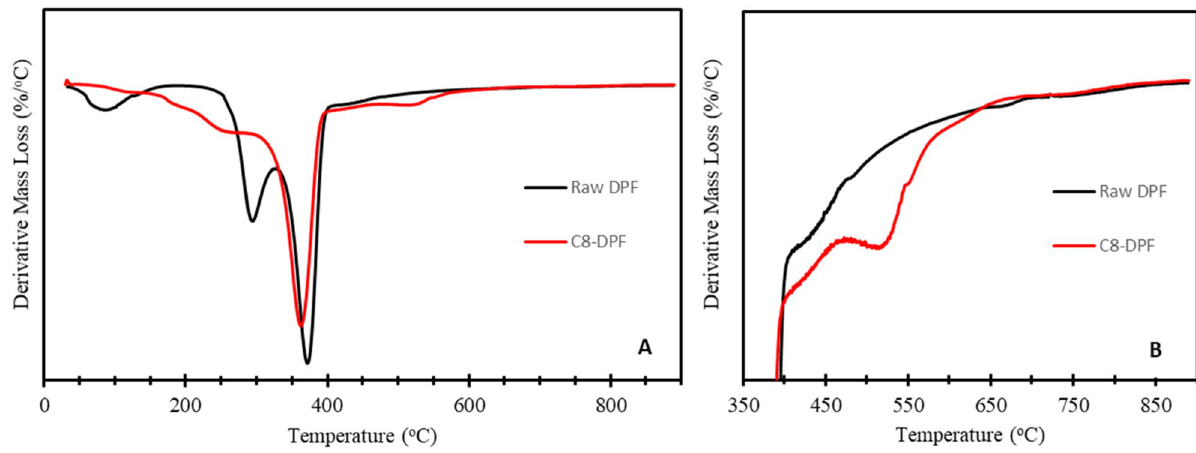
Figure 3. DTGA thermograms of raw DPF and